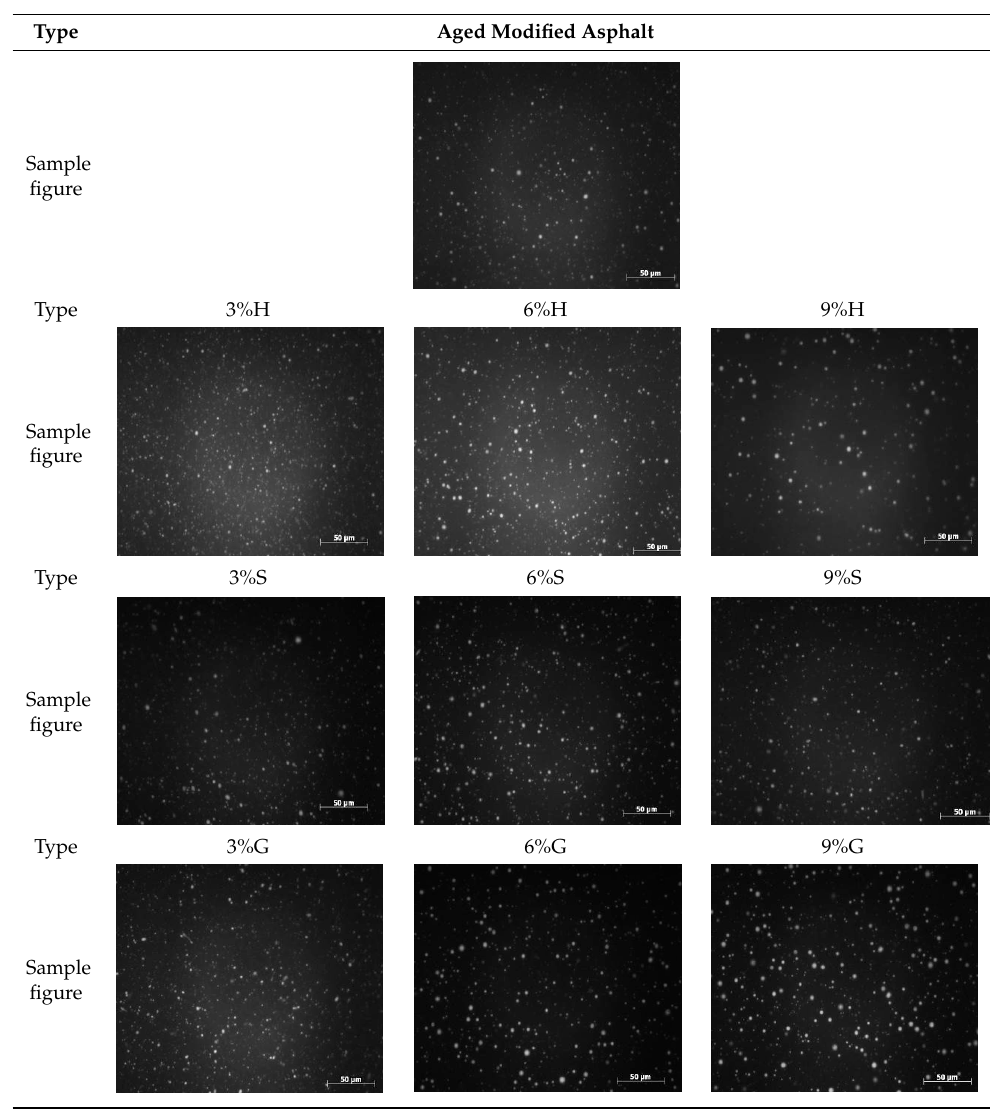
Table 8. Fluorescence micrographs of modified asphalt.